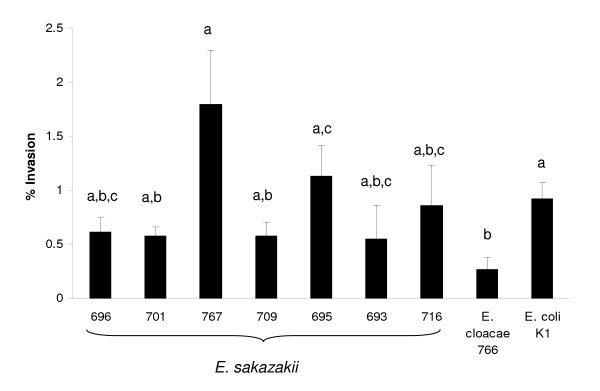
Gentamicin protection assay with rat rBCEC4 cells. Bacteria were grown overnight, inoculated and incubated for 1.5 h with rBCEC4 cells then treated with gentamicin for 30 min. E. coli K12 (non-invasive) and E. coli K1 (invasive) were used as controls. No bacteria were recovered at T0 following gentamicin treatment or following inoculation with E. coli K12. Results for T2 are presented as percent intracellular of the initial inoculation after 2 h. Strains without significant difference from E. coli K1 (p ≤ 0.18), 716(p ≤ 0.06) and 695(p ≤ 0.10), are designated by letter (a-c), respectively. All experimental strains had p values not significantly different from invasive (marked 'a'). Data are means ± standard errors from two independent assays performed in triplicate.